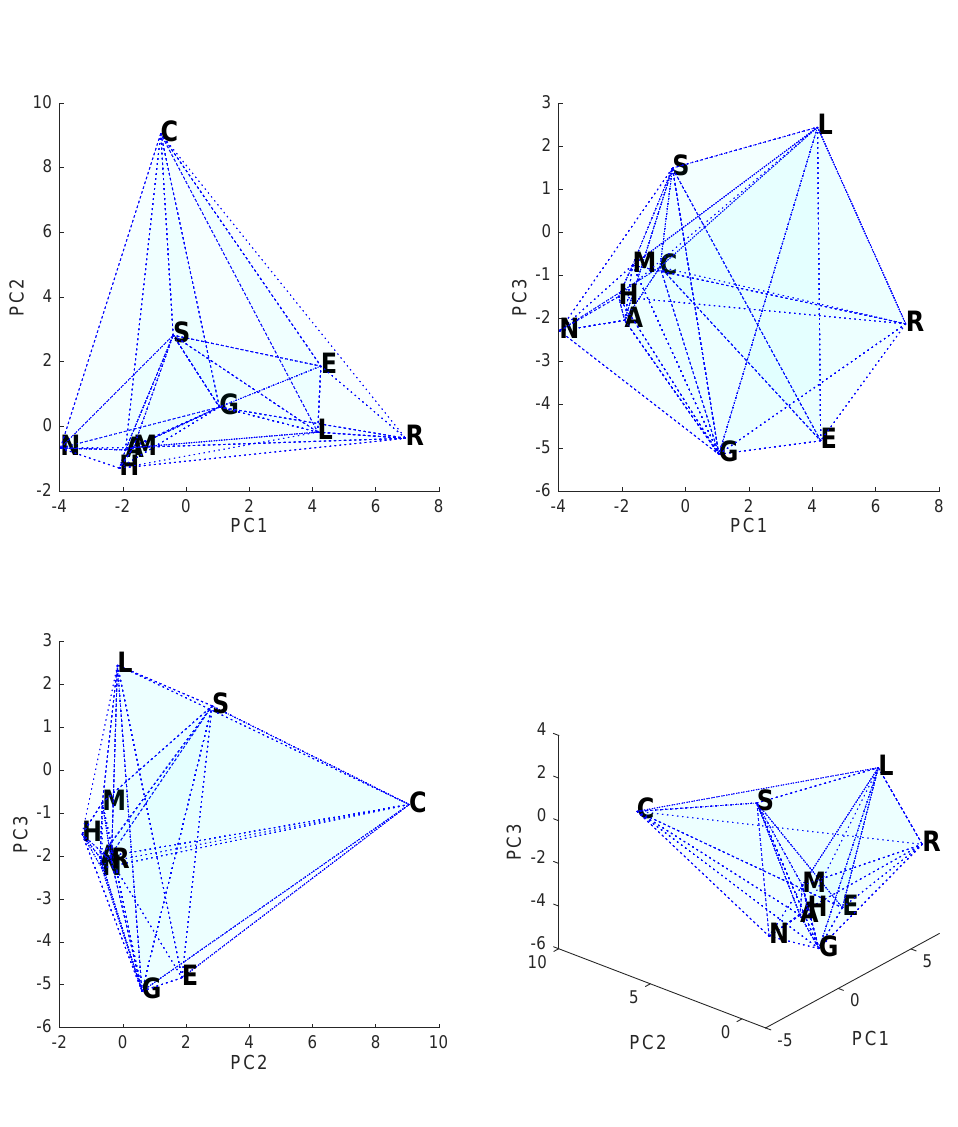
Figure 3. Delaunay triangulation of the data cloud from the case